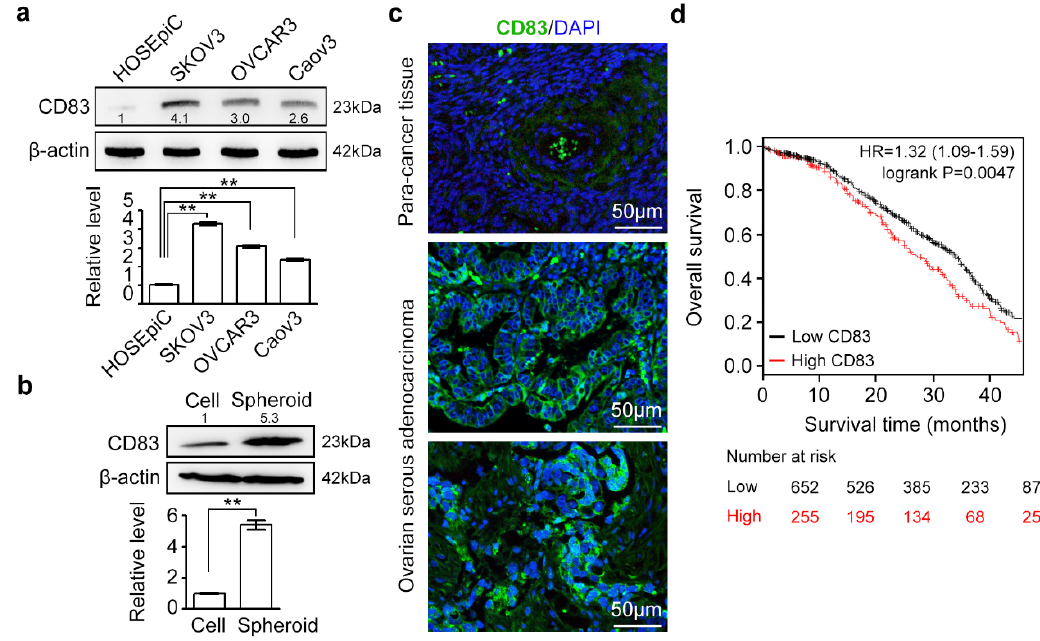
Figure 1. CD83 was ectopically activated in ovarian cancer cells / tissues, and its high expression predicted decreased survival rates. ( a ) Protein level of CD83 in human ovarian surface epithelial cell HOSEpiC and various ovarian serous adenocarcinoma cell lines (e.g., SKOV3, OVCAR3, and Caov3). PNGase F (NEB P0704S) was utilized to remove all N-linked oligosaccharides from glycoproteins. ( b ) The protein level of CD83 in SKOV3 cells and SKOV3 single cell-derived spheroids. The data in a and b were presented as the mean ± SEM; Student’s t -test; ** p < 0.01. ( c ) Expression and membrane distribution of CD83 (Abcam, ab205343) in ovarian serous adenocarcinoma and para-cancer tissue samples (OriGene, CT565862) were revealed by immunofluorescent staining. Scale bar, 50 µ m. ( d ) Kaplan–Meier analysis of overall survival based on CD83 levels in 907 ovarian cancer patients (low CD83 expression: 652, the high expression: 255) from the The Cancer Genome Atlas (TCGA) database. High expression of CD83 was closely relative to the reduced overall survival rates ( p =